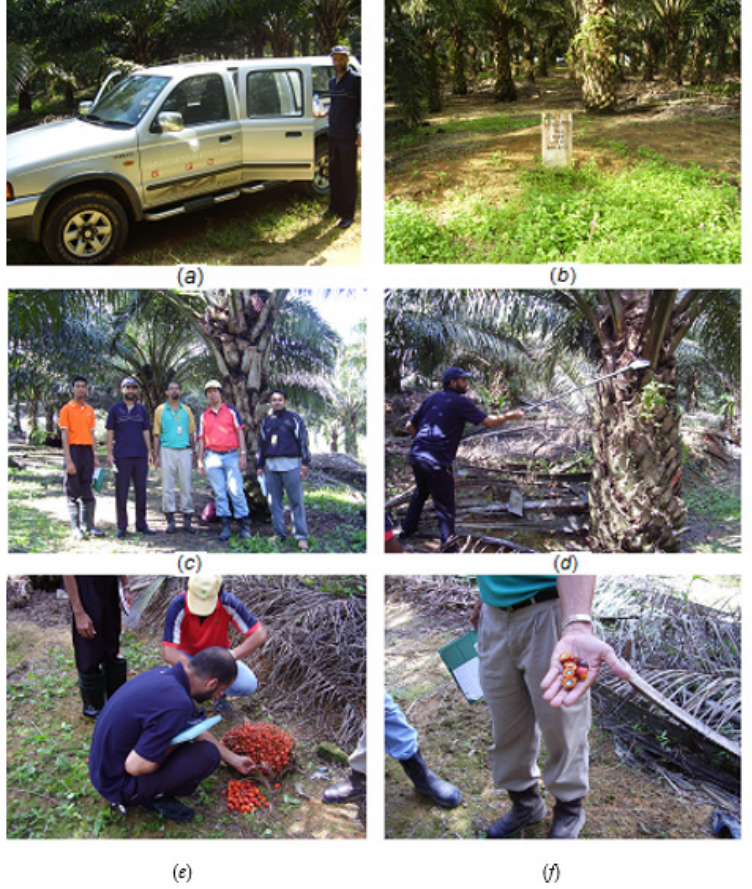
Figure 1. Excursion to MPOB Kluang: ( a ) transport, ( b ) MPOB oil palm field, ( c ) research group, ( d ) harvest method, ( e ) FFB sample and ( f ) FFB fruitlet.